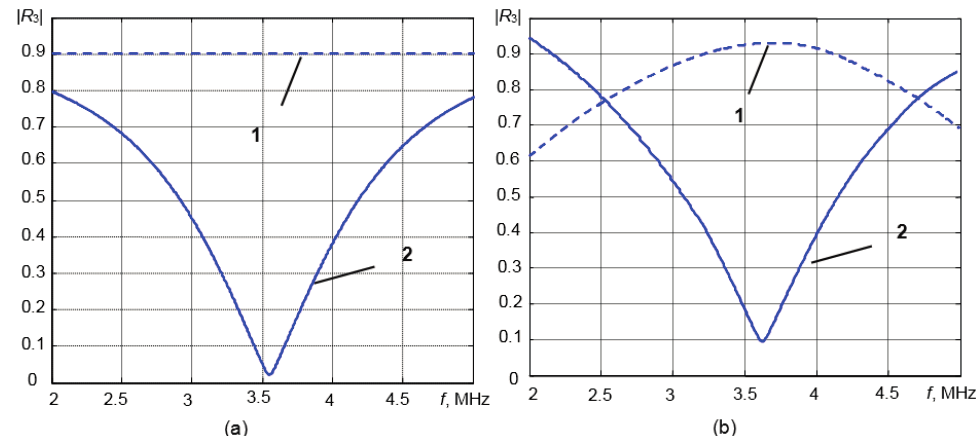
Figure 9. ( a ) Steel waveguide transducer reflection coefficient R 3 versus frequency (1D model); ( b ) steel waveguide transducer reflection coefficient R 3 versus frequency (3D model). 1, (dashed) without matching layer; 2, (line) with the λ /4 aluminum powder matching layer.